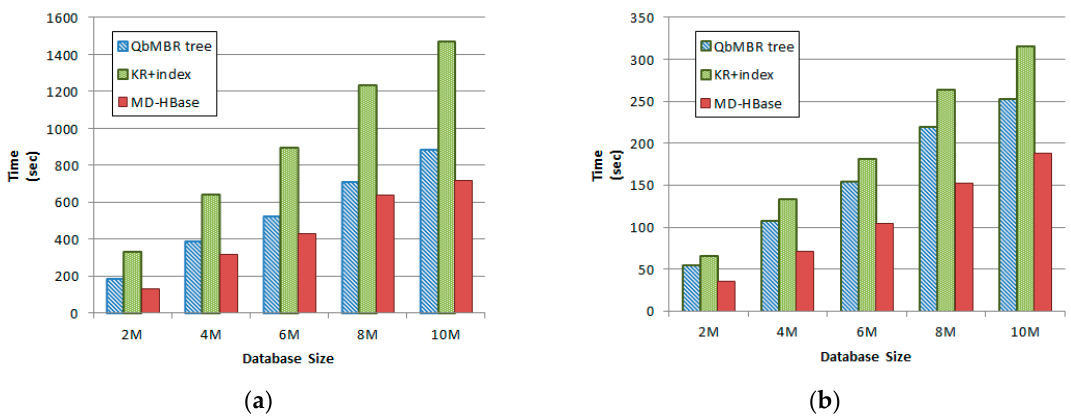
Figure 14. Time for index construction and update for different sized databases: ( a ) Time for index construction; ( b ) Time for incremental update of index.